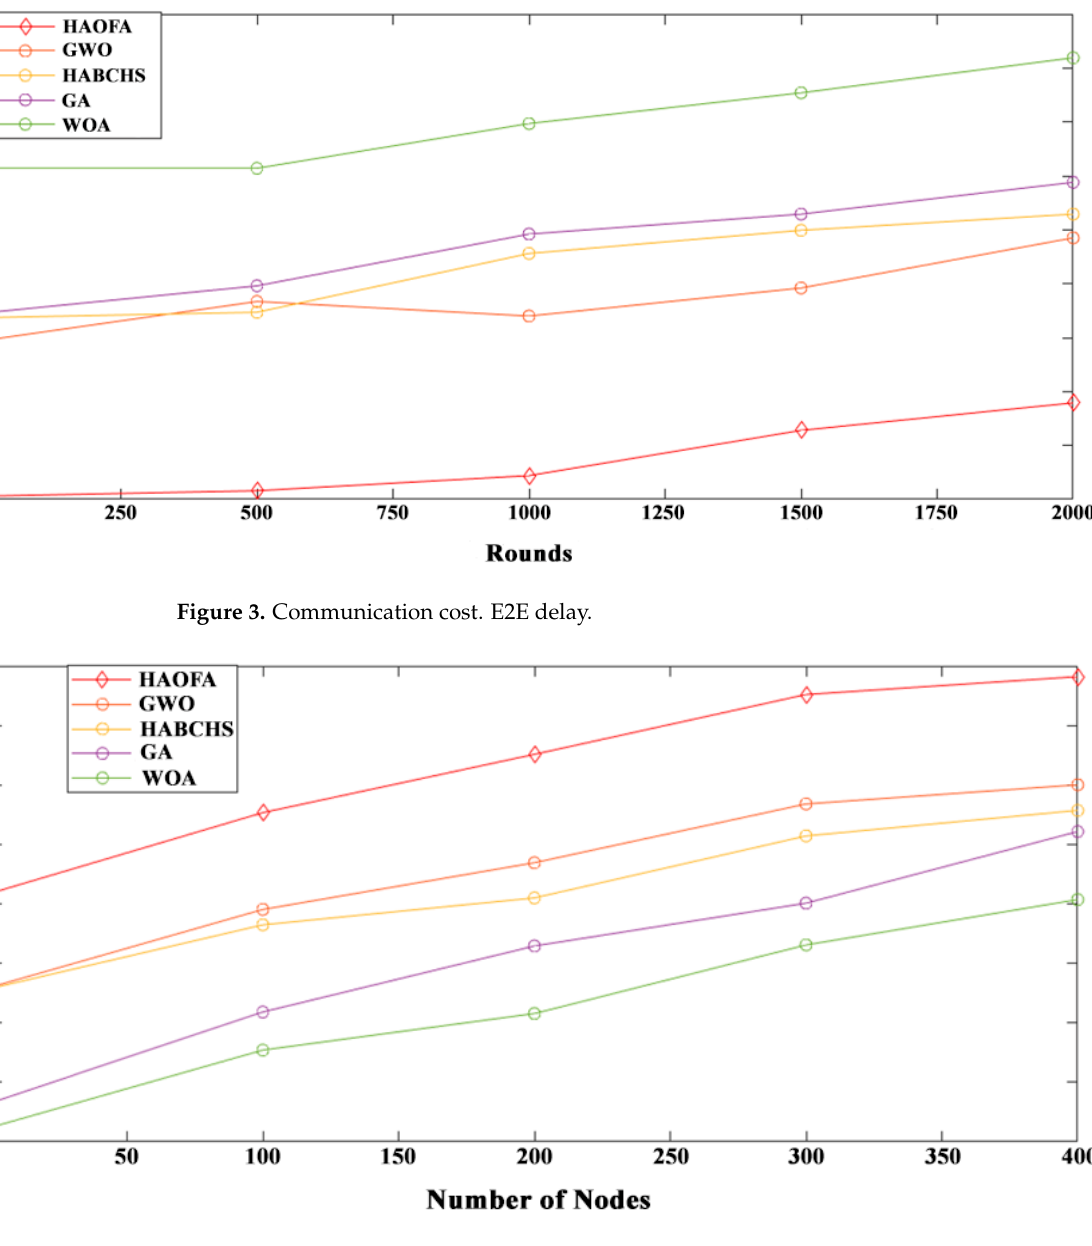
Figure 4. Throughput